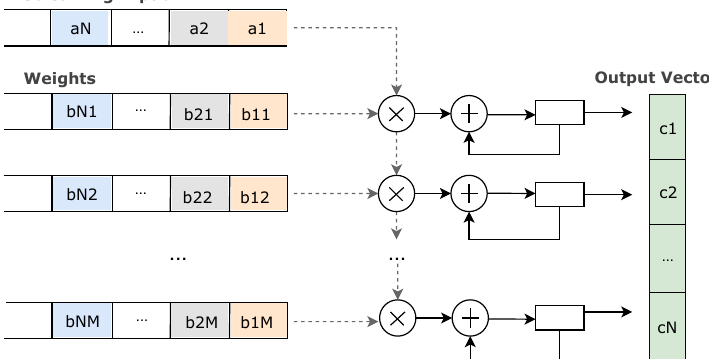
Figure 2. Dataflow optimization [13]: matrix multiplication is performed by implementing parallel FIR filters, facilitating data